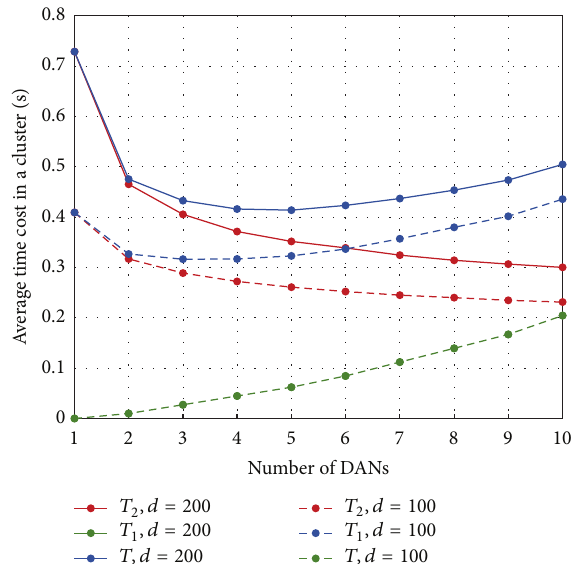
Figure 3: Performance comparison between the proposed and the ∗ 𝑇 (1) non-cooperative schemes versus different frequency resources ( 𝑤 𝑗 ) 𝑗 , 𝑗 ) versus with different number of DANs ( 𝑀 𝑗 = 2 , 5 ).